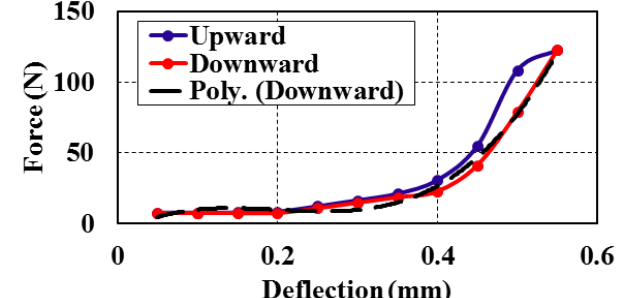
Figure 6. Relation between applied force versus the deflection of the piezoelectric